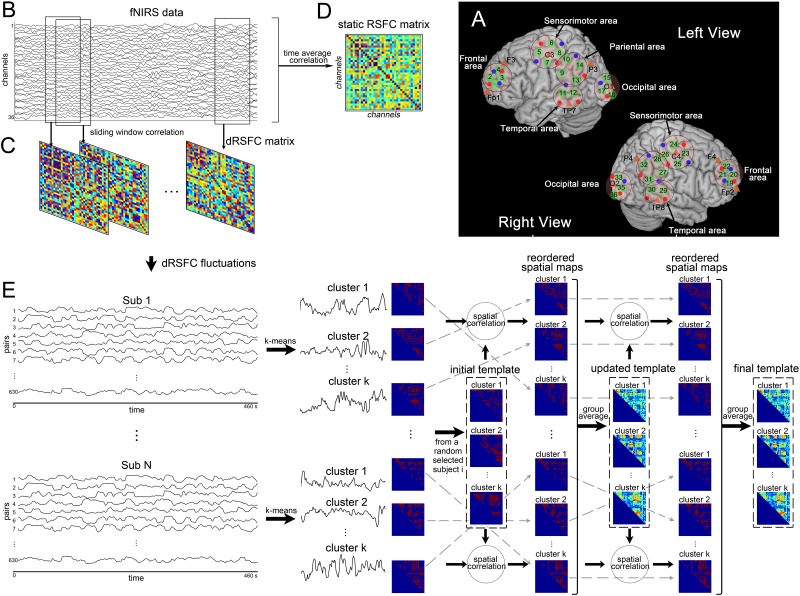
Illustration of functional near-infrared spectroscopy (fNIRS)-based dynamic resting-state functional connectivity (dRSFC) analysis. (A) Anatomical positions of the fNIRS standard-distance channels. Green represents the 36 fNIRS measurement channels. Red and blue dots represent the fNIRS emitters and detectors, respectively. The five ROIs were marked by black circles in the left and right views. The short-distance channels are not demonstrated here; two of these were near channels 4 and 22, and the other two were near channels 9 and 27. (B) An example of fNIRS data from a random selected subject. (C) Static RSFC analysis. The static RSFC was calculated from the time courses of the entire scanning between any two channels. (D) Dynamic RSFC analysis. The dRSFC was calculated between any two measurement channels using a sliding-window correlation approach. In this approach, a time window with a fixed length was selected and then shifted along the entire time course in a fixed step. Within each time window, the RSFC was calculated for each pair of measurement channels using the Pearson correlation method. This process results in quantification of time-varying dRSFC over the whole scanning. Owing to the connectivity matrix is symmetric, the effective number of connection pairs among all the 36 measurement channels is C362 = 630. (E) Pipeline of clustering analysis of the dRSFC fluctuations.